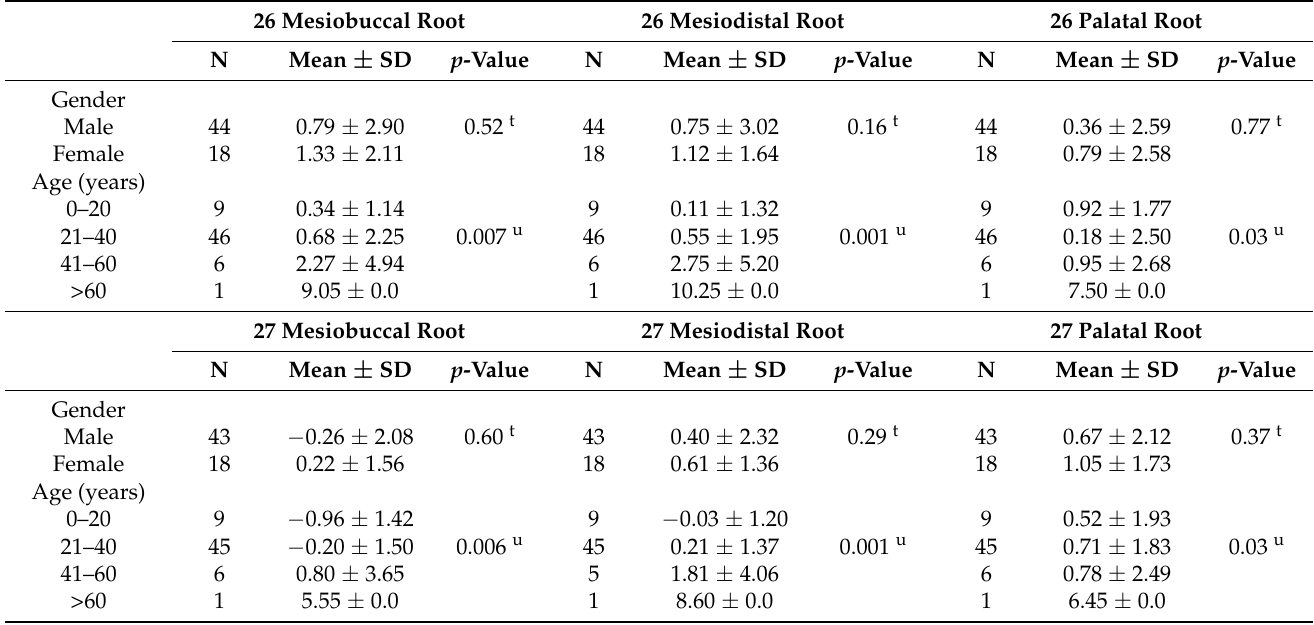
Table 6. Measurements of distances (mm) between apices of left 1st and 2nd molar roots and floor of the maxillary sinus concerning age and gender ( n =